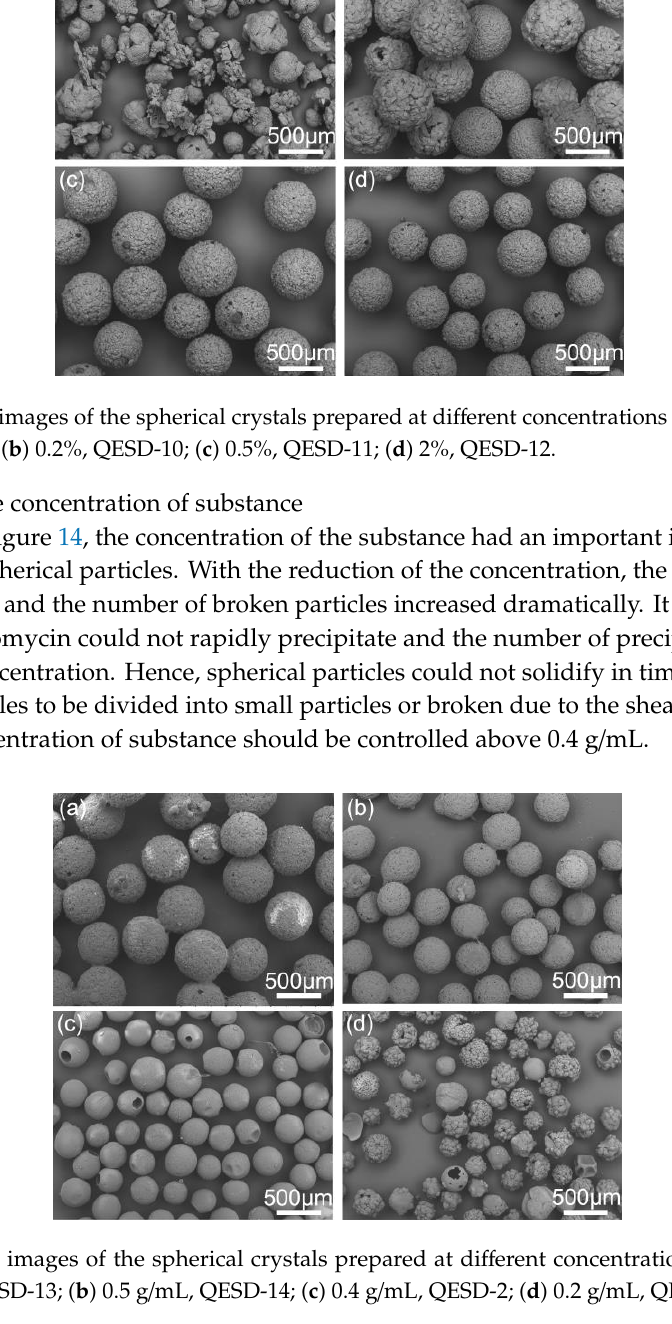
QESD-5; ( b ) 300 rpm, QESD-6; ( c ) 400 rpm, QESD-7; ( d ) 600 rpm, QESD-8.